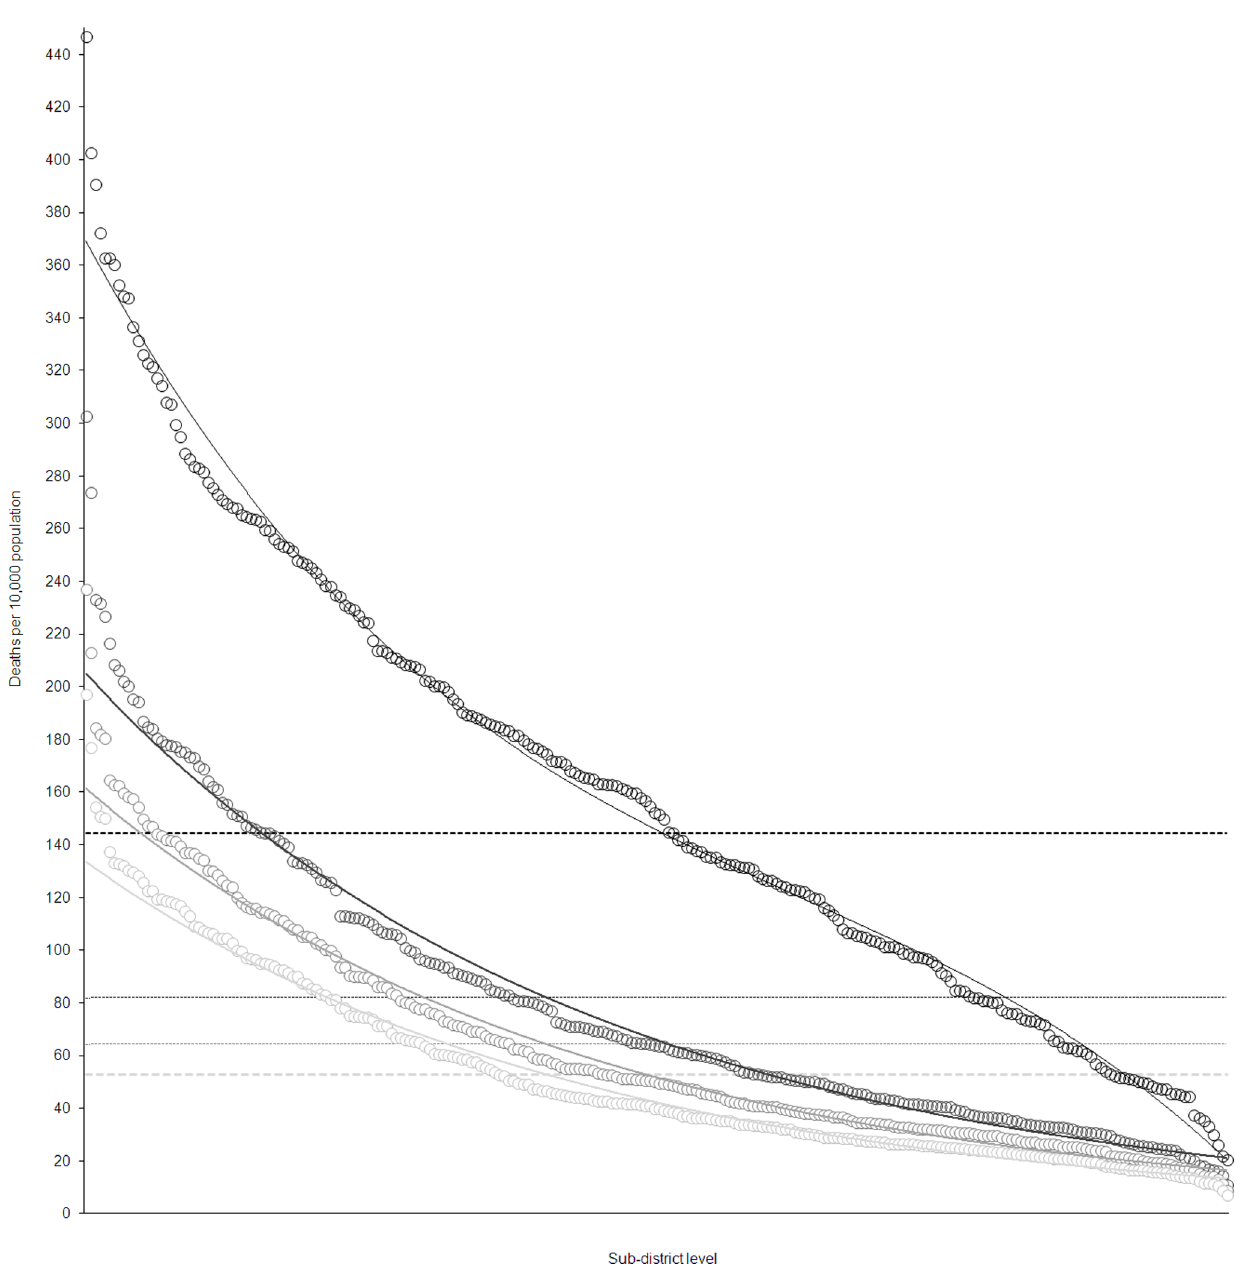
Figure 5. Mortality proportion by quaternary unit: observed and projections based on attributable factor removal based on quaternary unit level prevalence of exposure, South Africa, 2007. Local municipalities are ordered from highest to lowest mortality: black curve represents the observed mortality; dark grey curve represents adjusted mortality following removal of the most attributable local municipality factors, grey curve following removal of the secondary most attributable factors, light grey line following removal of the tertiary most attributable factors. Overall average reductions are displayed using horizontal dash lines of the same colour.